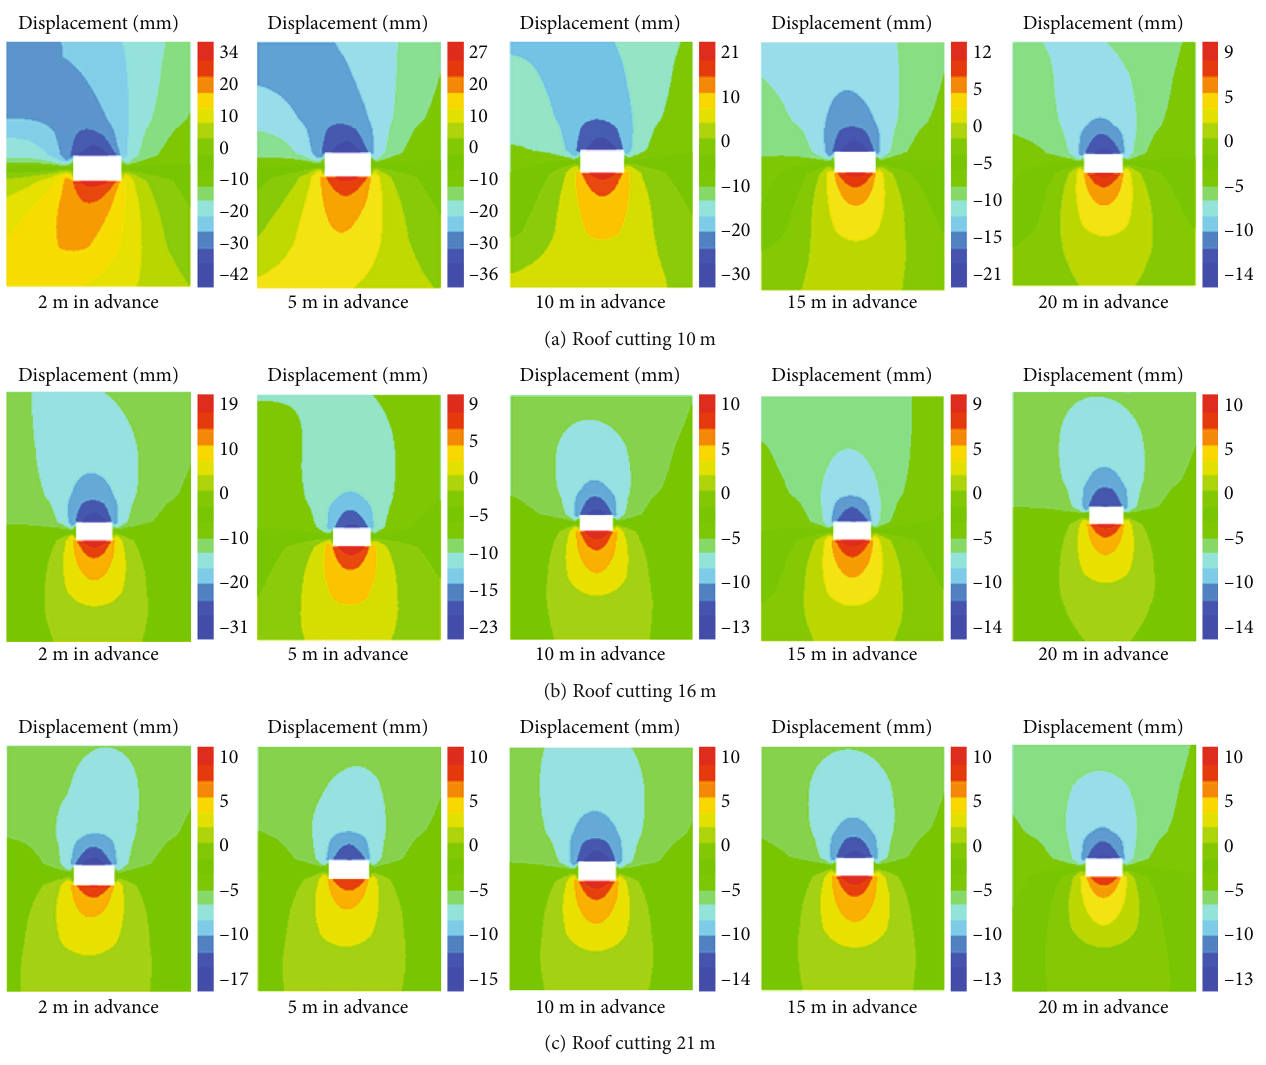
Figure 8: Simulation test results of roof